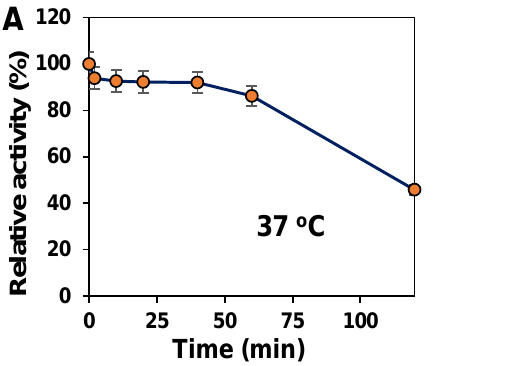
Figure 3. The stability of the recombinant Chon-ABC at 37 °C ( A ) and 4 °C ( B ) in 75 mM pH 8.0 PBS.